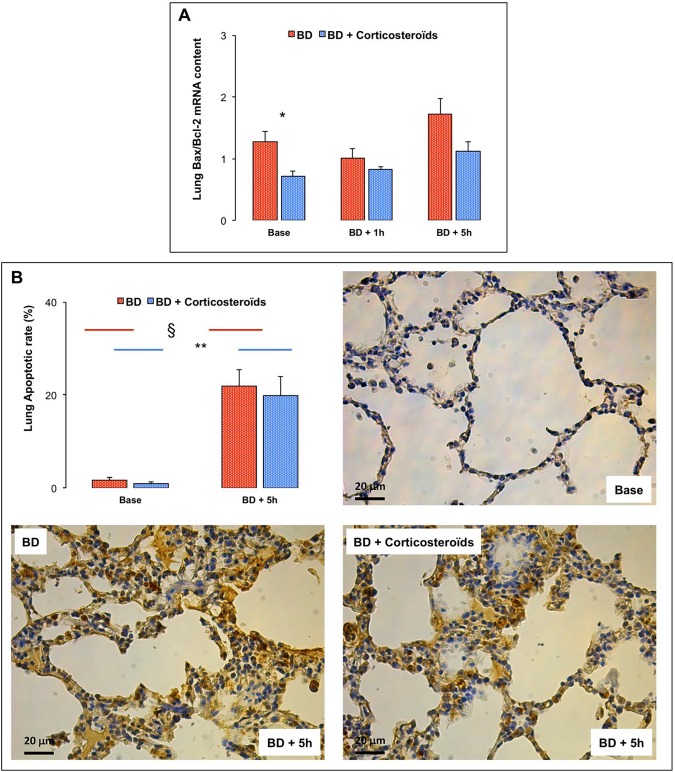
Lung apoptosis in brain death (BD)-induced lung injury with and without methylprednisolone pretreatment.Panel A. Pro-apoptotic Bax-to-Bcl-2 mRNA ratio at baseline, one (BD + 1 hour) and five (BD + 5 hours) hours after Cushing reflex in the placebo-pretreated brain death (BD group; n = 11; red bars) and in the methylprednisolone-pretreated brain death (BD + Corticosteroids group; n = 8; blue bars) groups. Panel B. Lung apoptotic rate (percentage) was evaluated as the ratio between the numbers of the terminal deoxynucleotidyl transferase biotin-dUTP nick-end labelling (TUNEL)-positive cells (brown nuclei) and the total number of cells (brown + blue nuclei) at baseline and five hours (BD + 5 h) after Cushing reflex in the placebo-pretreated brain death (BD group; n = 11; red bars) and in the methylprednisolone-pretreated brain death (BD + Corticosteroids group; n = 8; blue bars) groups. Illustrative microscopic TUNEL-immunostained lung sections (magnitude 400x) at baseline and at 5 hours after Cushing reflex in the BD and the BD + Corticosteroids treated pigs. Values are expressed as mean ± SEM. * p<0.05 BD versus BD + Corticosteroids; § p<0.05 Base versus BD + 5 hours in the BD group; ** p<0.05 Base versus BD + 5 hours in the BD + Corticosteroids group.